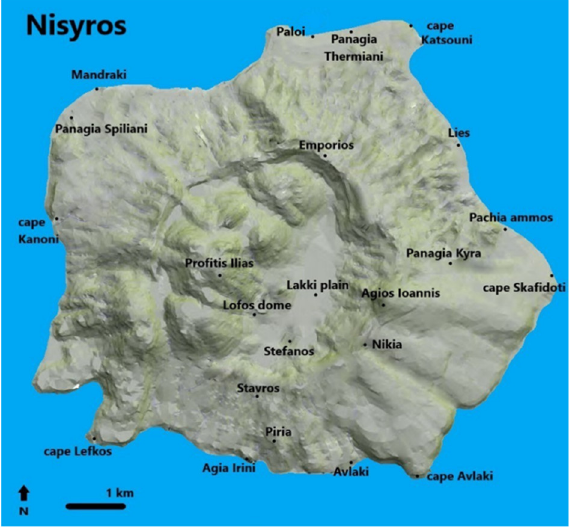
Figure 4. 3D representation of the surface of Nisyros Island, indicating the location of places referred in the text [52], modified.